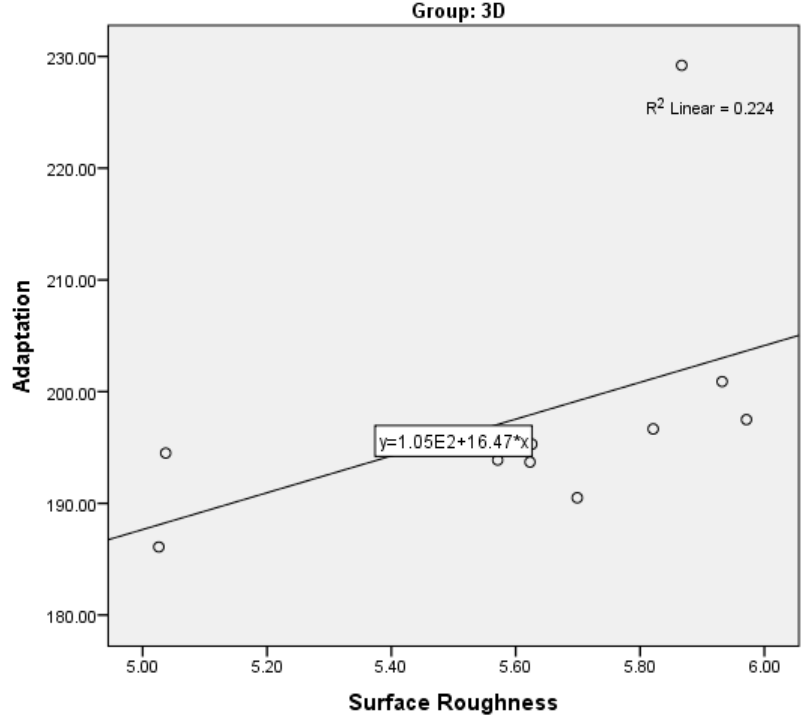
Figure 9. Scatter plot for the correlation between adaptation and surface roughness for the 3D samples.